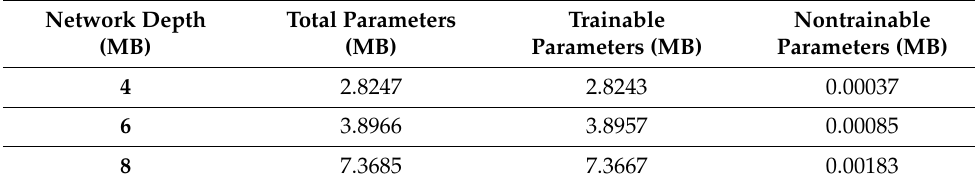
Table 3. Network parameters at different depths.